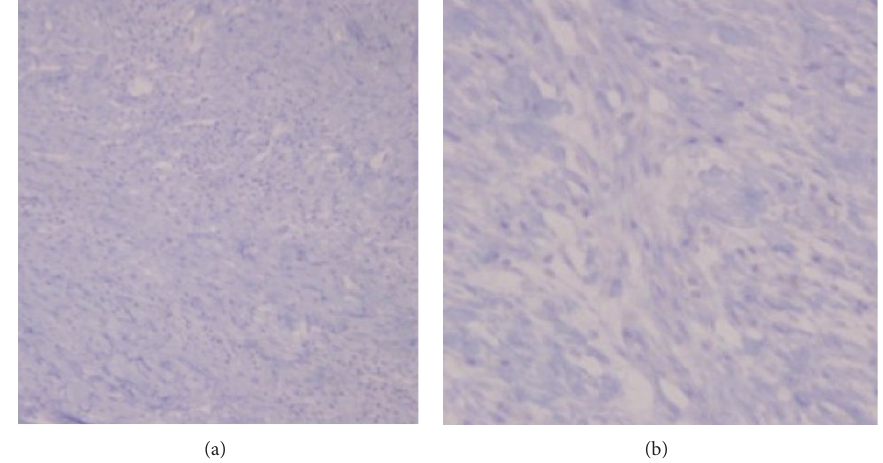
Figure 4: Absence of ALK expression by immunohistochemical staining ((a): × 100, (b): ×